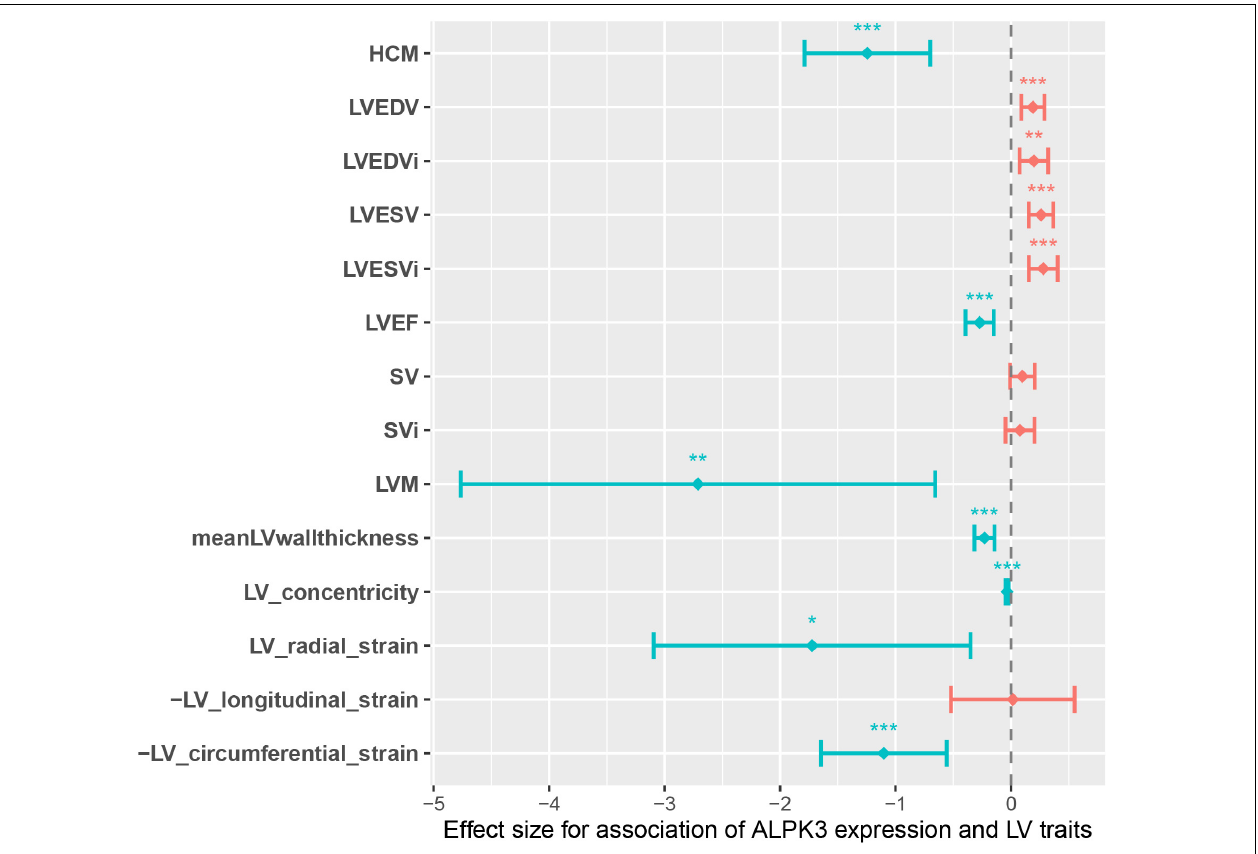
FIGURE 3 | Genotype-inferred ALPK3 expression-to-LV trait associations. Center values are the estimated association effect size and error bars indicate 95% confidence interval. Data shown correspond to that in Supplementary Table 7 . LV, left ventricle/ventricular; LVEDV, LV end-diastolic volume; LVEDVi, body-surface-area (BSA) indexed LVEDV; LVESV, LV end-systolic volume; LVESVi, BSA indexed LVESV; LVEF, LV ejection fraction; SV, stroke volume; SVi, BSA indexed SV; LVM, LV mass; meanLVwallthickness, mean LV wall thickness. * P < 0.05, ** P < 0.01, *** P <